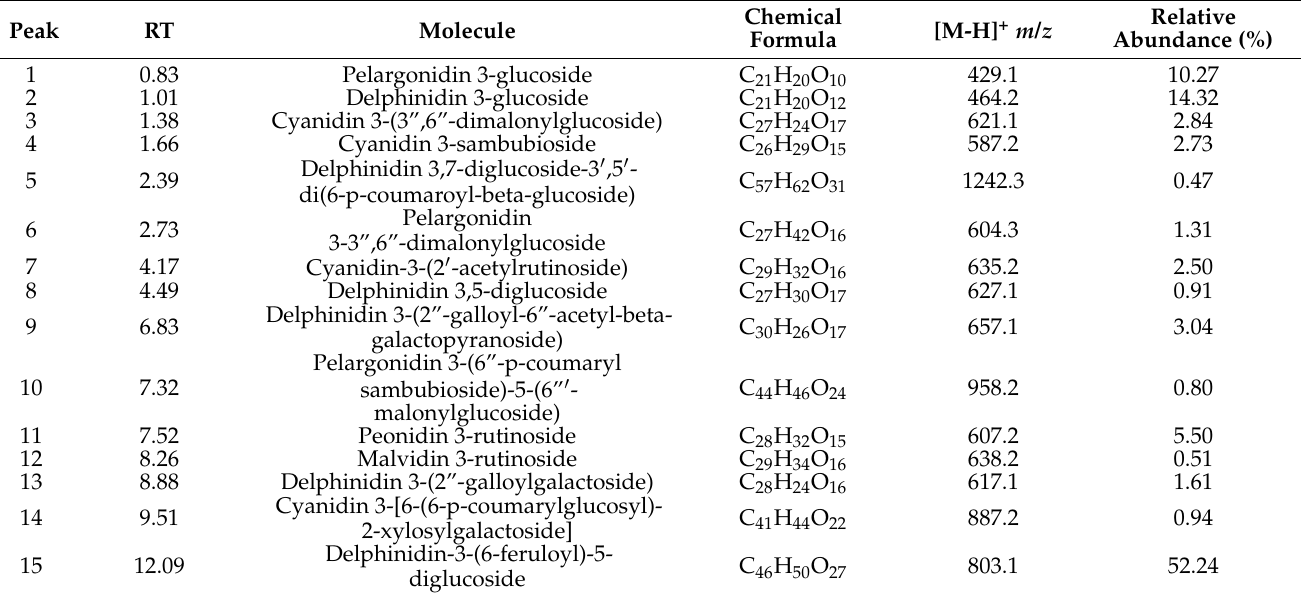
Table 3. Anthocyanins identified by LC-MS/MS analysis for aqueous extracts of in vitro plant of A. chilensis .